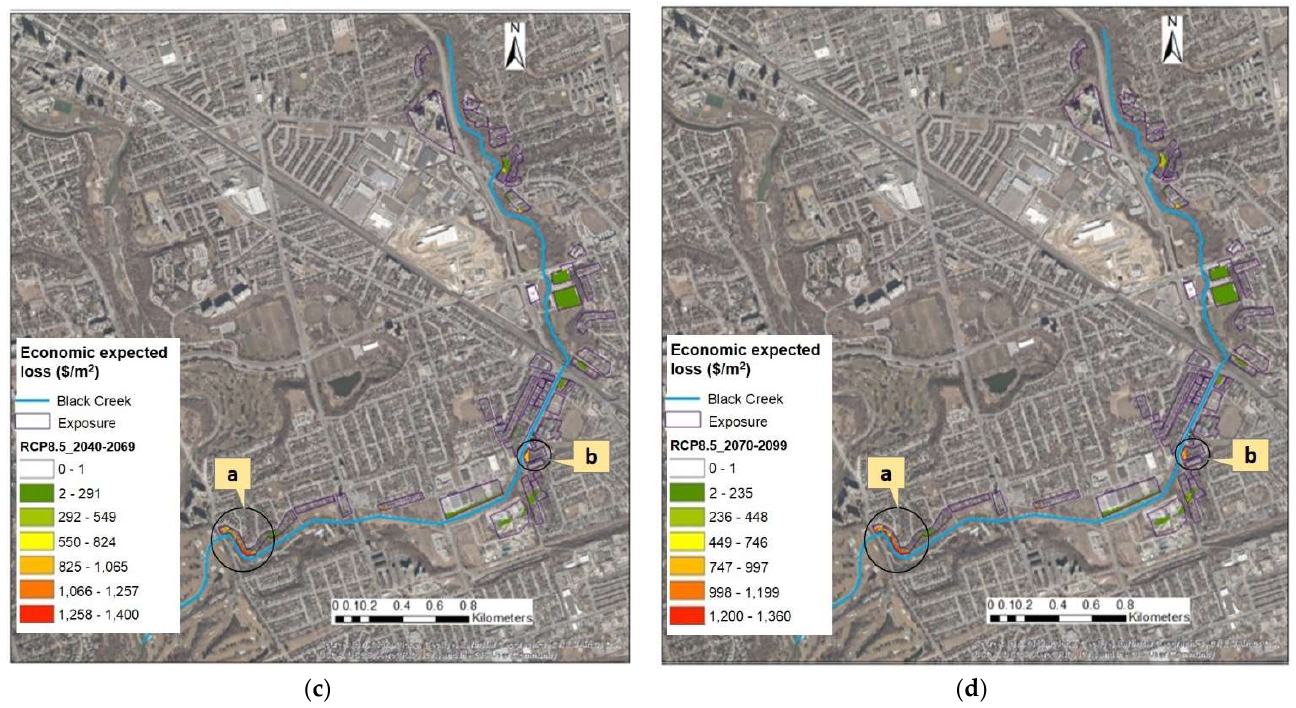
Figure 15. Economic expected loss maps for the ( a ) historic period and RCP 8.5 ( b ) short-term period; ( c ) medium-term period; ( d ) long-term period.